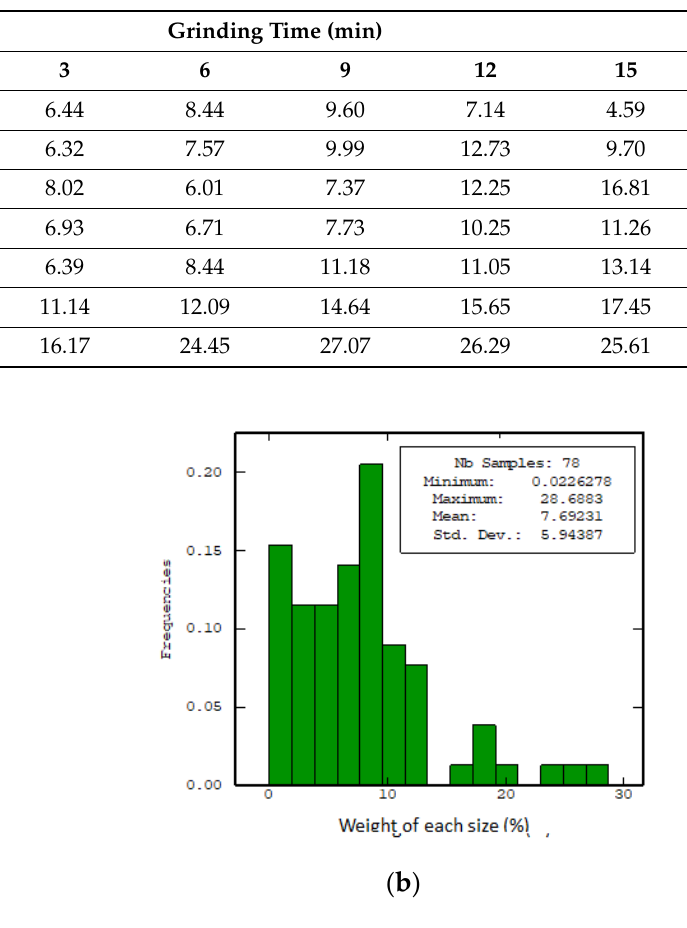
Figure A1. Histogram of the input data using LGP-2. ( a ) Ore-A. ( b ) Ore-B.